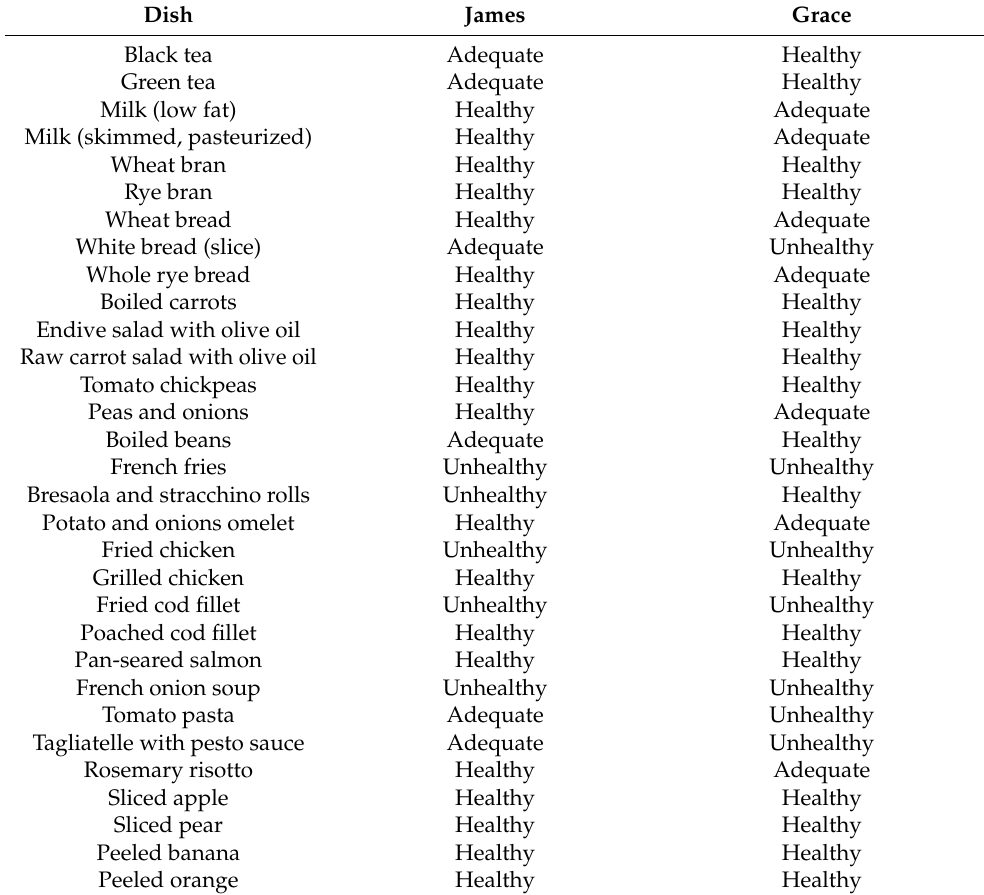
Table 3. Inferred classification of the dishes modeled in HeNuALs ontology for each of the use cases